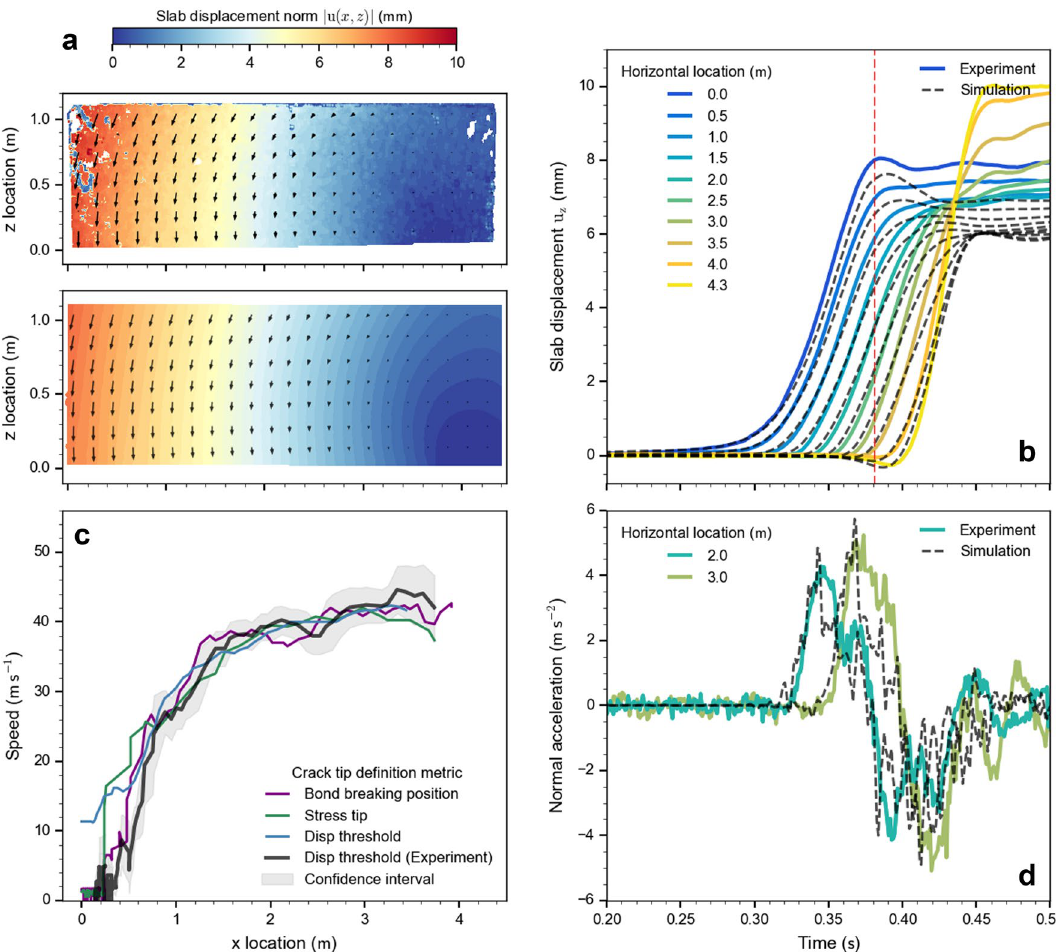
Figure 3. Comparison of experimental and simulated PST results. ( a ) Experimental (top) and simulated (bottom) displacement field norm (magnitude) when the crack tip reached 3.7 m ( The displacement field is colored from no-displacement in blue to 10 mm displacement in red. ( b ) Temporal evolution of the normal displacement averaged over the height. The colors represent the horizontal location and the black dashed line the corresponding location for the simulated PST. The red dashed line corresponds to the time when the crack tip reached 3.7 m, i.e. corresponds to the displacement field shown in ( a ). ( c ) Crack speed evolution along the PST beam. The grey line shows the experimental crack speed with its confidence interval (grey envelope) and the blue, violet and green lines the simulated crack speed. Crack speeds are computed from different crack tip definitions: grey and blue line based on displacement threshold of 0.2 mm, green line based on maximum stress and violet line based on the position of breaking bonds. ( d ) Temporal evolution of the normal slab acceleration for two locations [at 2 m and 3 m; line colors as in ( b